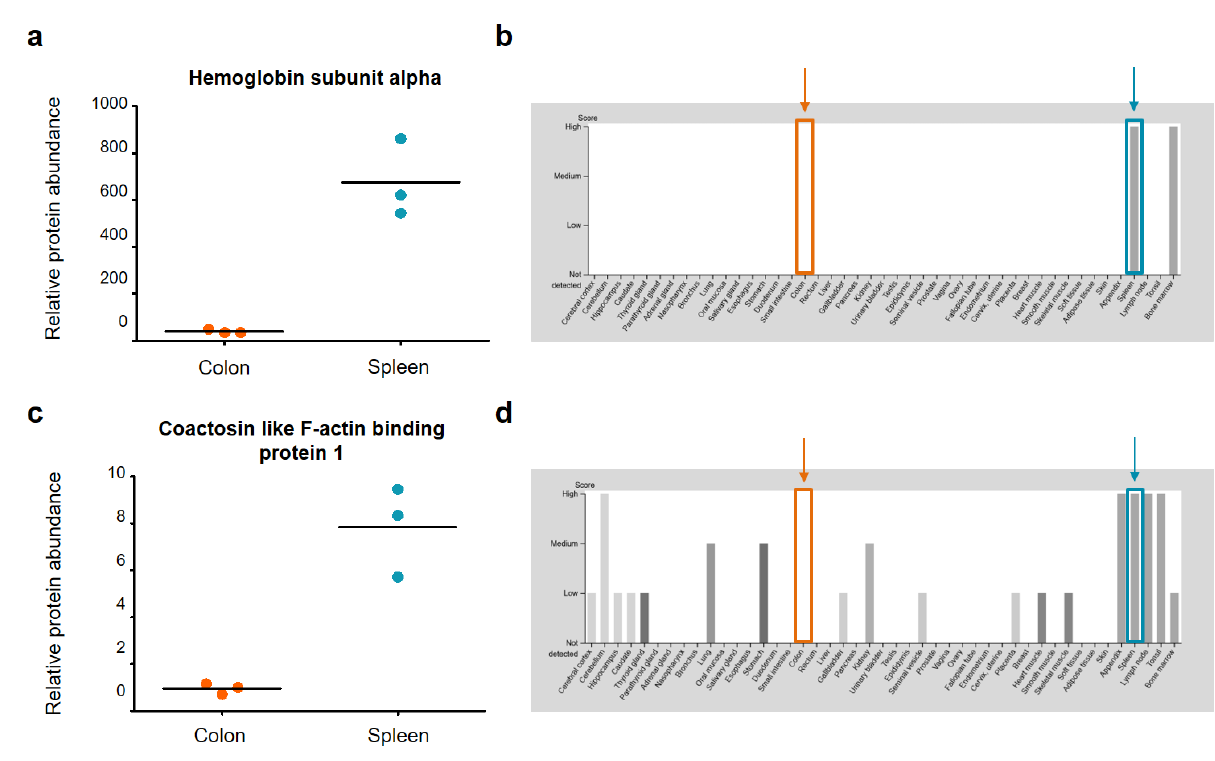
Figure 6. Relative protein abundance plots for ( a ) hemoglobin subunit alpha (Hba) and ( c ) coactosin like F-actin binding protein 1 (Cotl1) in murine colon and spleen samples. The corresponding protein abundance data of the Human Protein Atlas (HPA) [30] is shown in ( b ) for Hba and ( d ) for Cotl1. A total of 44 different tissue types were examined for the protein abundance data of the HPA. The data in ( a , c ) is highlighted in orange for colon tissue and in blue for spleen tissue. Images ( b , d ) are available from